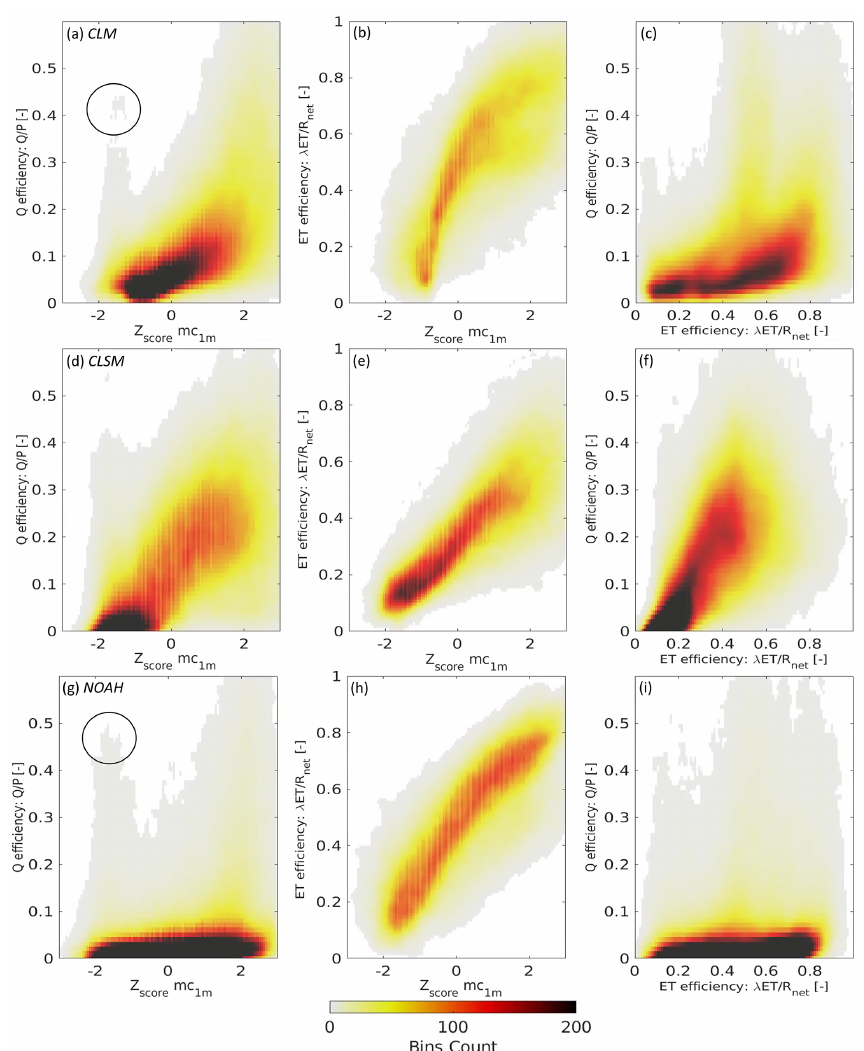
Figure 8. Scatter density clouds representing the fitted curves in efficiency space of all pixels inside the Dry Chaco for the BL experiment for the period 1992–2015 for (a–c CLM, (d–f) CLSM and (g–i) NOAH, respectively. (a, d, g) Q efficiency, (b, e, h) ET efficiency and (c, f, i) ET vs. Q